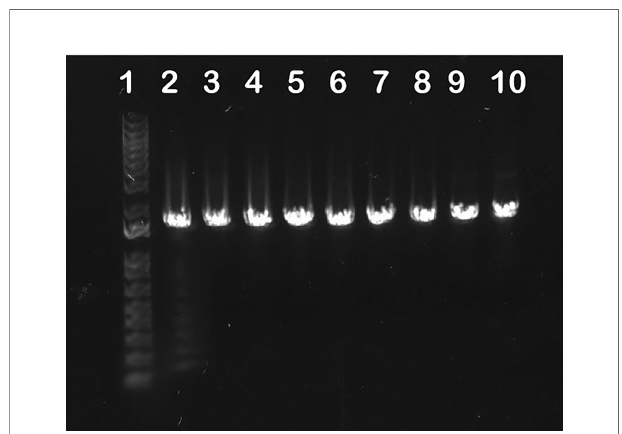
FIGURE 2 | S. aureus ureC carriage. PCR using the ureC-Forward and ureC-Reverse primers ( Table 2 ) was performed to con fi rm the presence of the ureC gene within clinical S. aureus isolates. The presence of an amplicon around 1.6 Kb indicates all the strains tested encoded ureC . Numbers denote lanes: (1) Ladder, (2) JE2, (3) UTI MRSA, (4) HUC 86, (5) HUC 86-02, (6) HUC 95, (7) HUC 97-02, (8) HUC 100, (9) HUC 100-01, (10) HUC